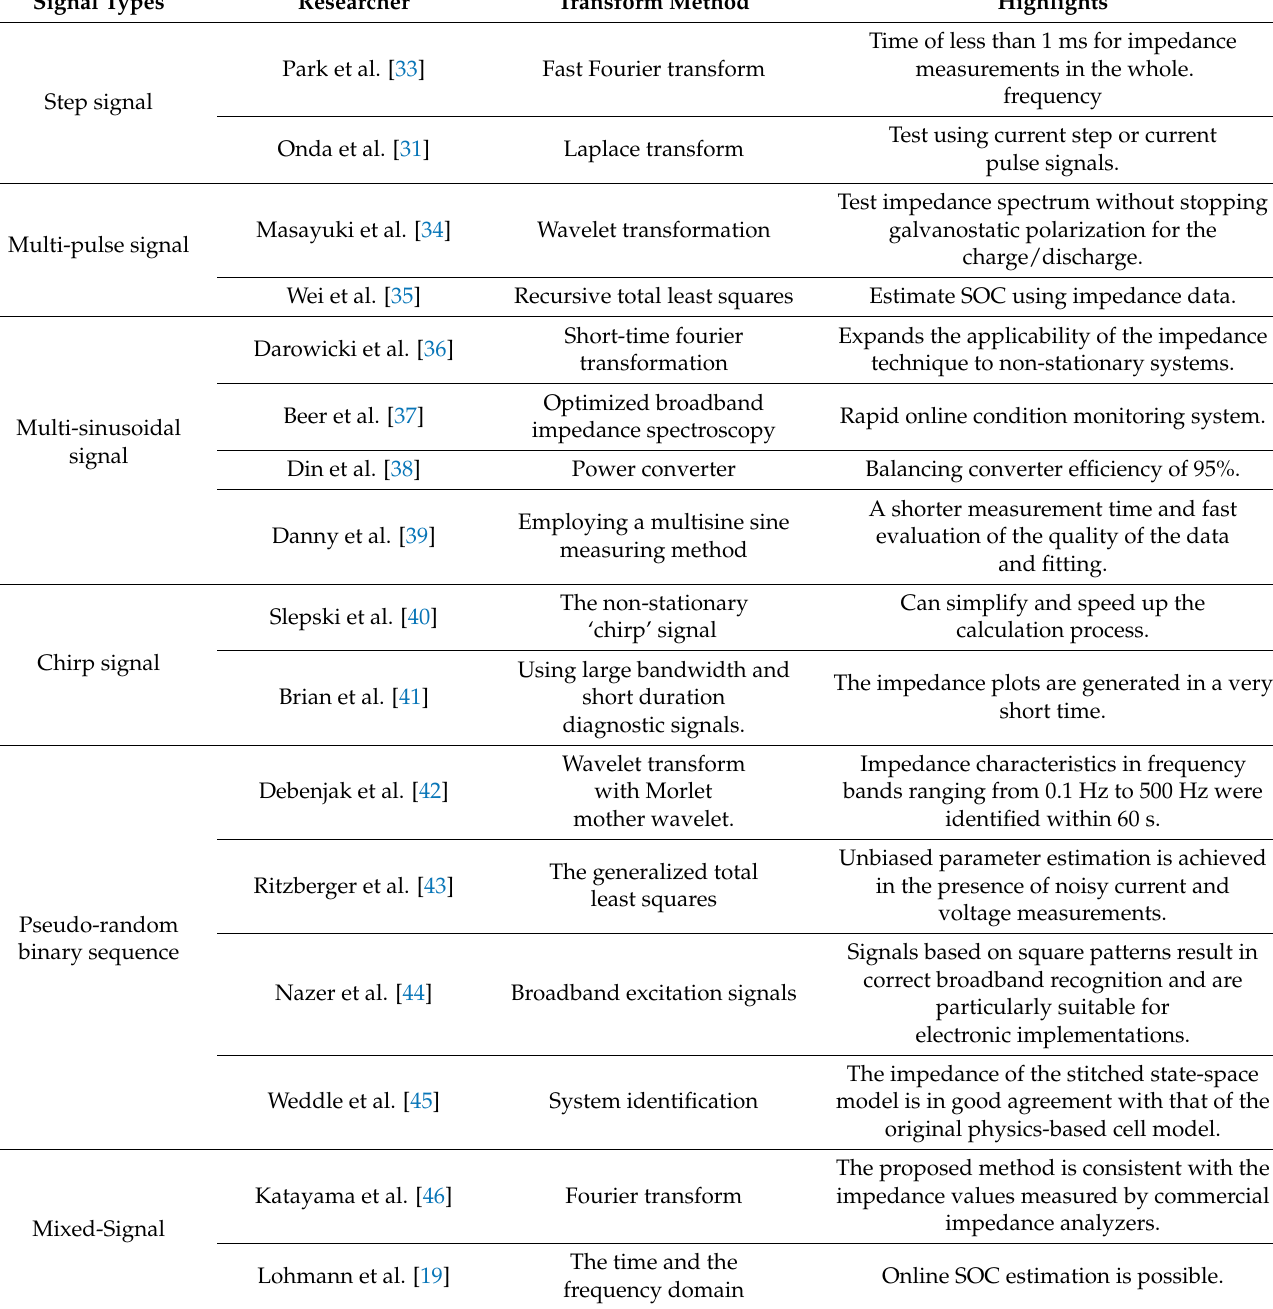
Table 1. Summary of acquisition techniques of electrochemical impedance